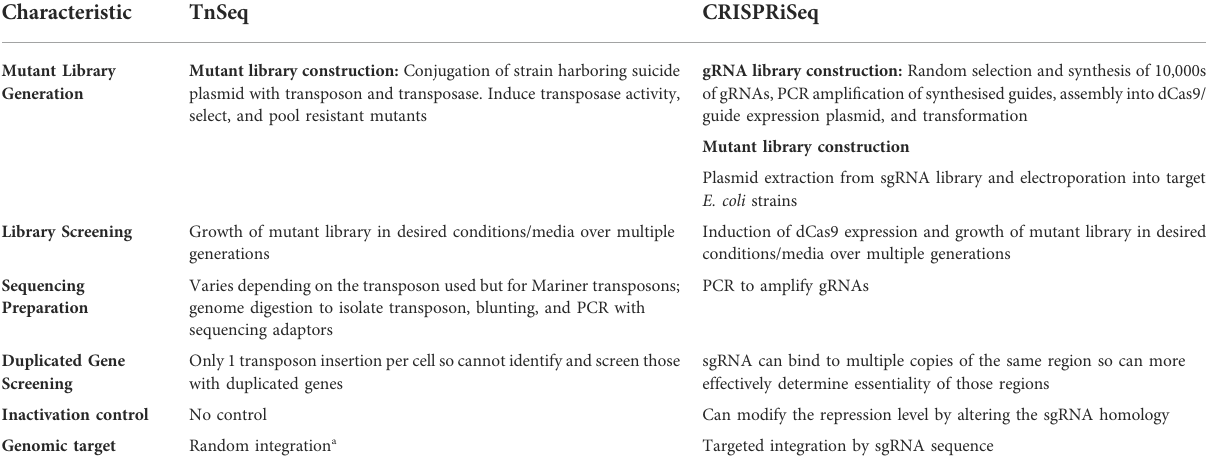
TABLE 1 Comparison between TnSeq and CRISPRiSeq methods to determine gene essentiality. Characteristic